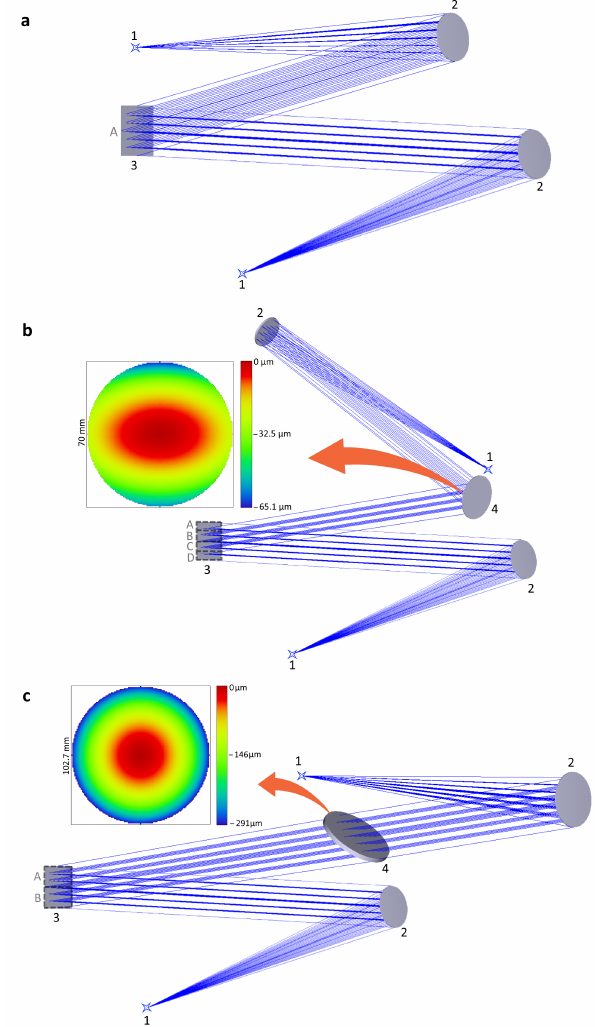
Figure 2. Holographic grating recording setups: ( a )—classical grating, ( b )—composite grating, ( c )—simplified composite grating. The setup elements are: 1—laser point sources, 2—collimating mirrors, 3—hologram substrate, 4—auxiliary optics for the wavefront control; A, B, C and